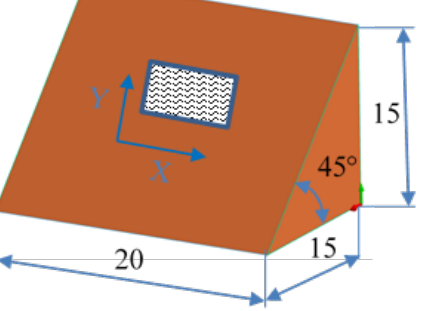
Figure 8. Sample geometry used for the roughness analysis (printing position).